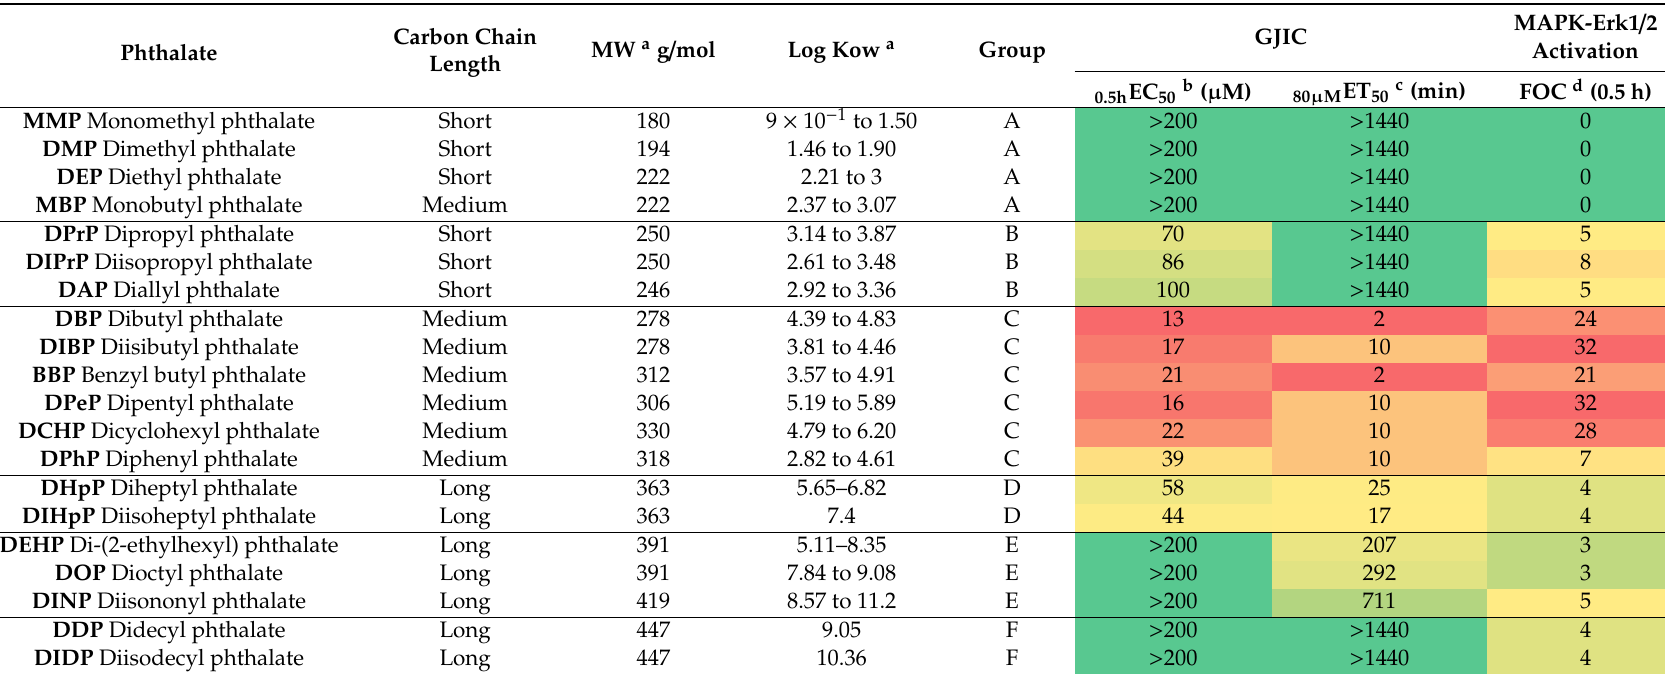
Table 1. Overview of the studied phthalates and their structures, physico–chemical properties, and biological activities, based on which they were distinguished into six groups—group A–F. The color scale is green to yellow to red with higher e ff ects getting the green color and low or no e ff ects getting the red